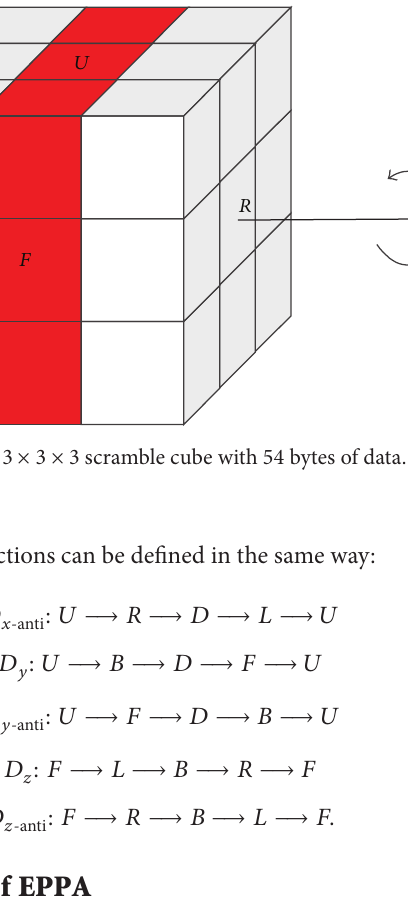
Figure 5: Unfolded scramble cube arrange